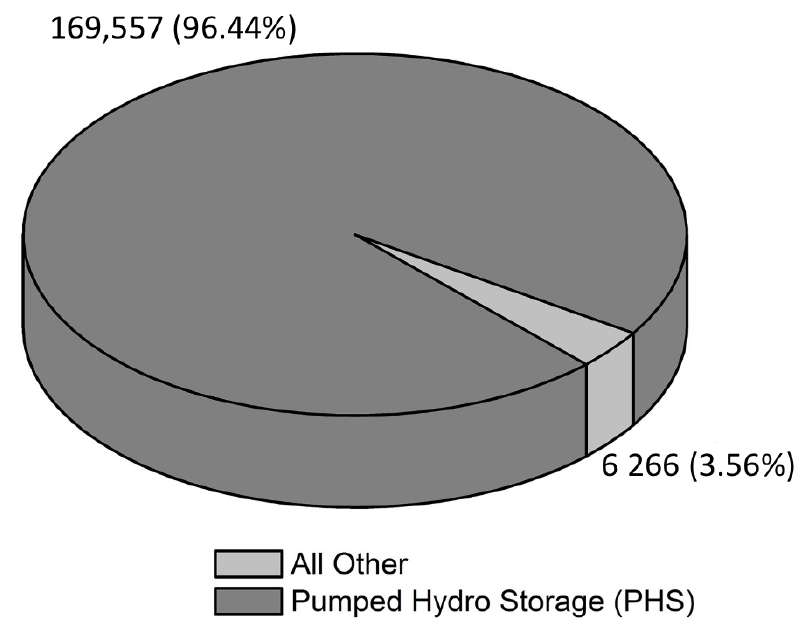
Figure 3. Grid-connected operational capacities of all storage technologies, all capacities are in MW [10].